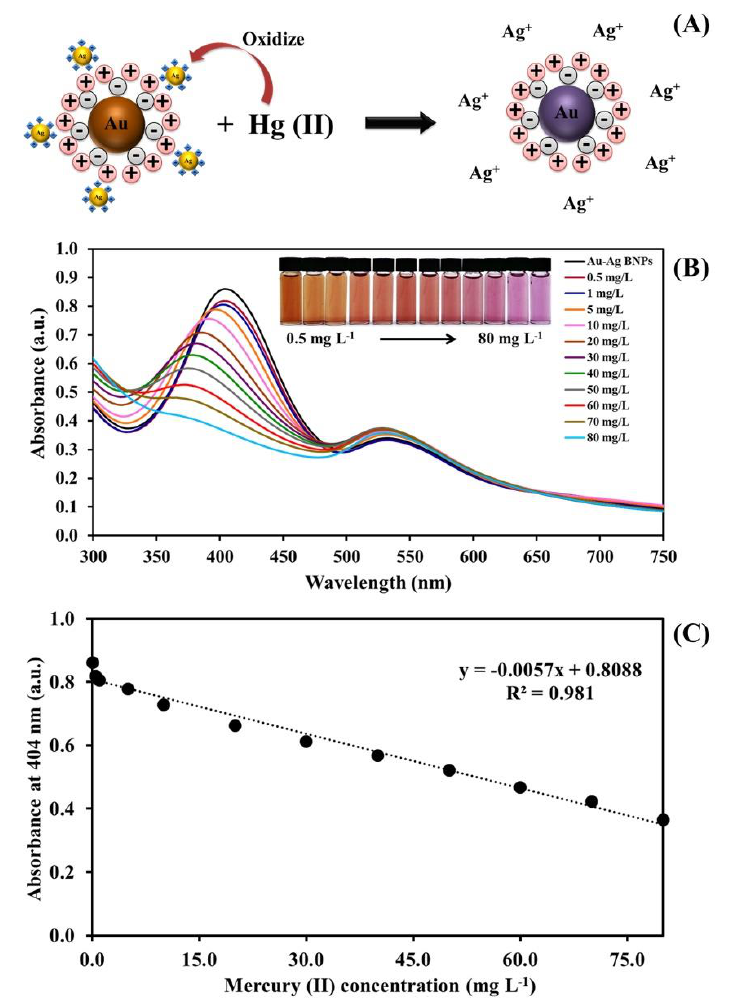
Figure 5. ( A ) The mechanism for colorimetric response of the Au-Ag BNPs to mercury (II), ( B